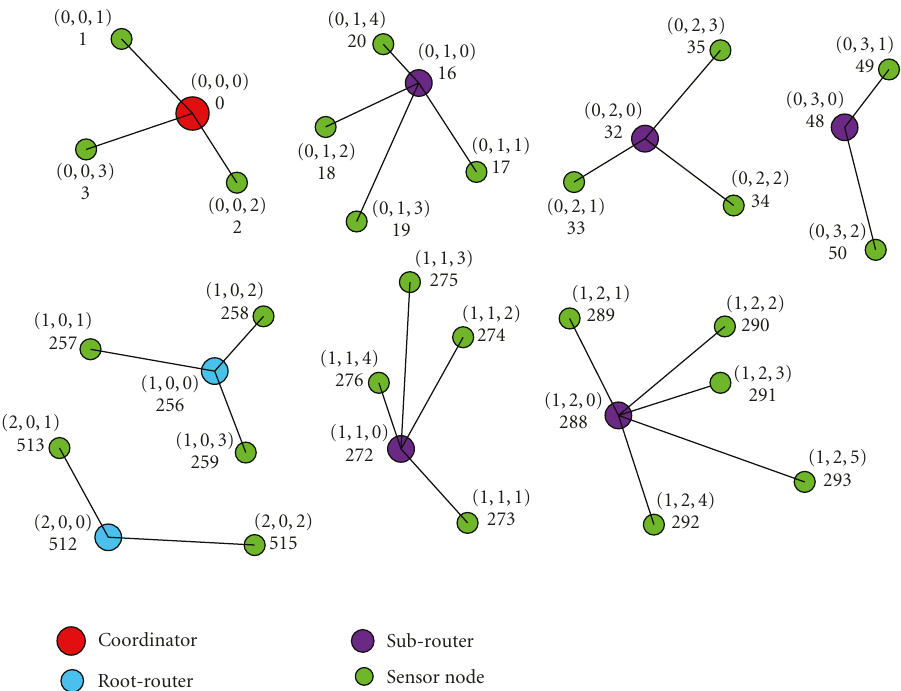
Figure 10: A sample irregular ZigBee network, using 3D AACS